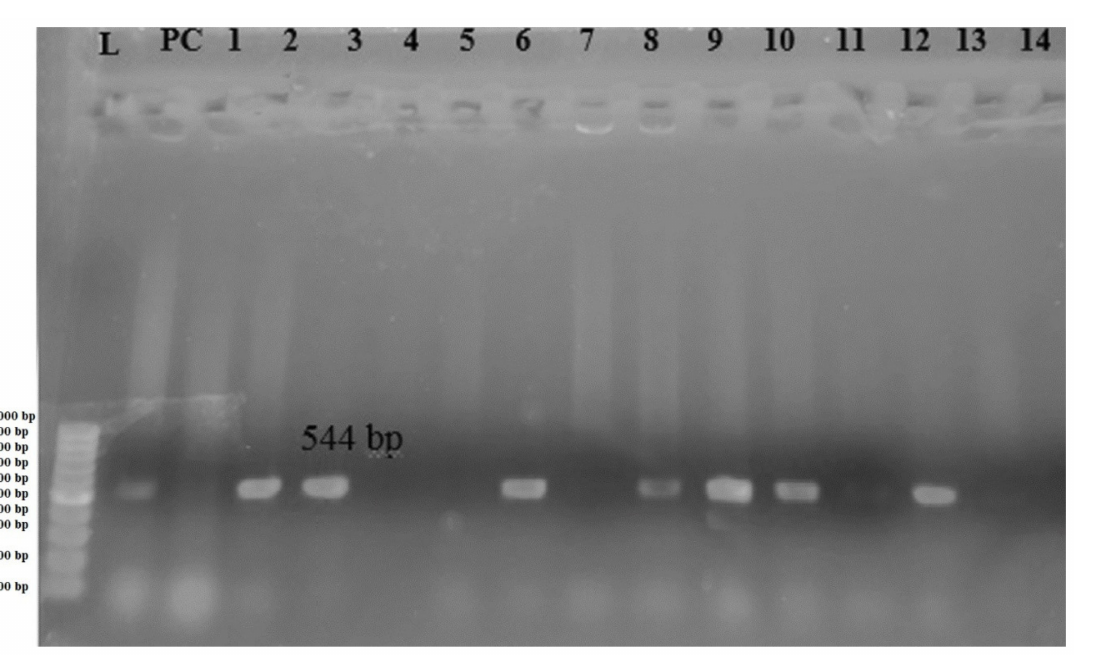
Figure 2. Gel electrophoresis of PCR amplified bla CTX-M gene, Lane L: DNA ladder, Lane PC: Positive control, Lane 1–14: 544 bp PCR product of bla CTX-M